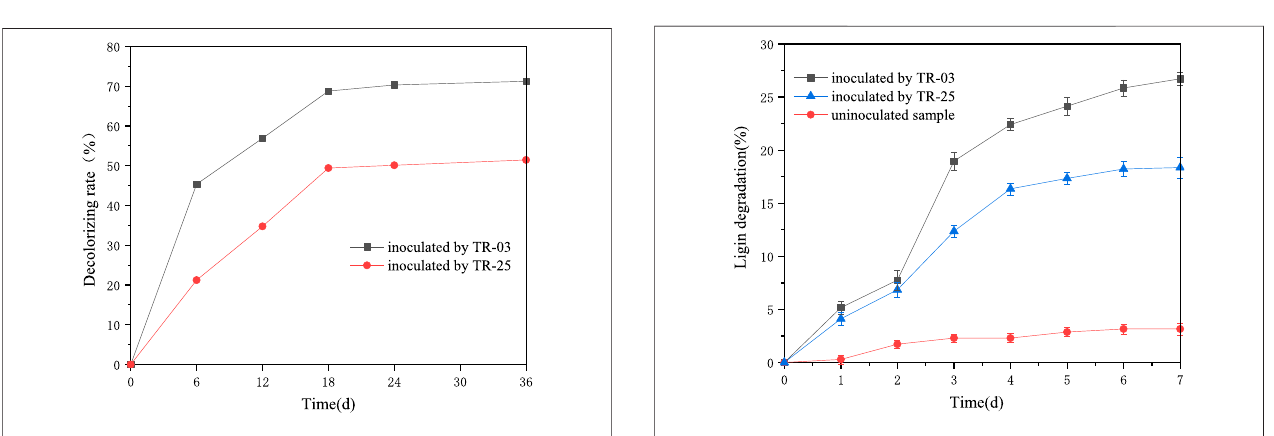
FIGURE 3 | Dye decoloration of Azure-B (0.01%) by TR-03 and TR- 25 at 590 nm.